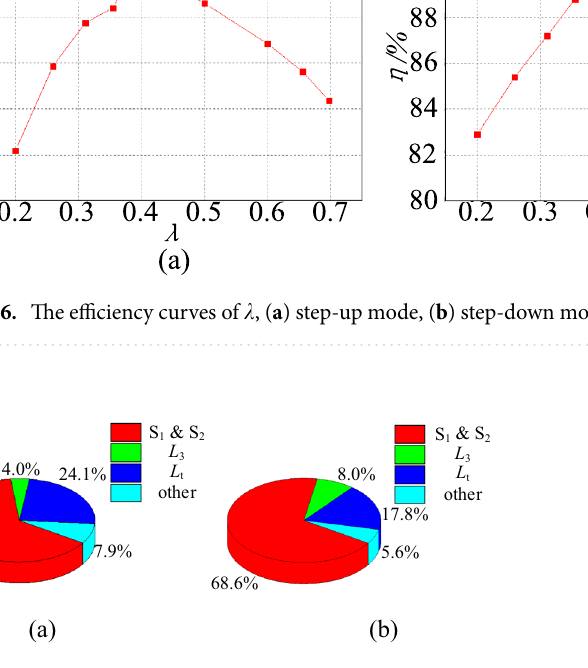
Figure 27. The experimental loss of the proposed converter, ( a ) step-up mode, ( b ) step-down